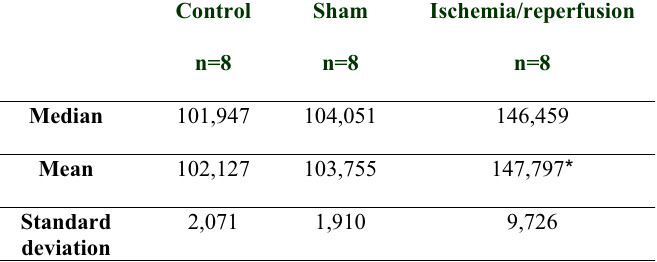
n = size of the sample (eight rats each)